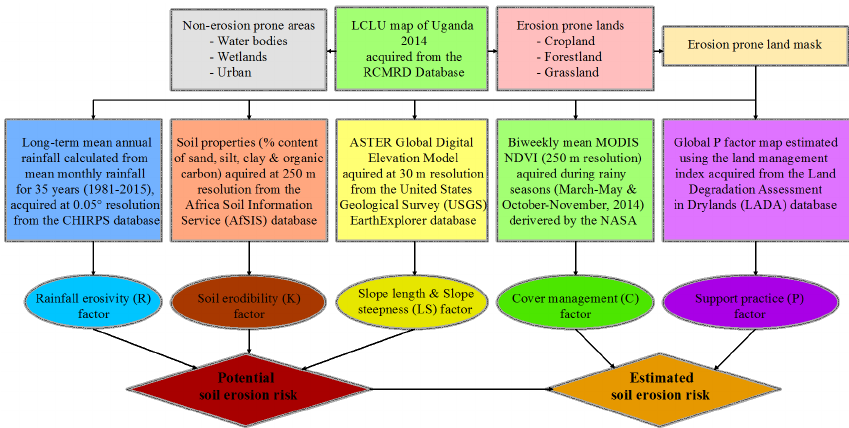
Figure 2. Flowchart used for modeling soil erosion risk by water in Uganda. LCLU: Land Use and Land Cover, RCMRD: Regional Centre for Mapping of Resources for Development, CHIRPS: Climate Hazards Group InfraRed Precipitation with Station data, ASTER: Advanced Space borne Thermal Emission and Reflection Radiometer, MODIS: Moderate Resolution Imaging Spectroradiometer, NDVI: Normalized Difference Vegetation Index, NASA: National Aeronautics and Space